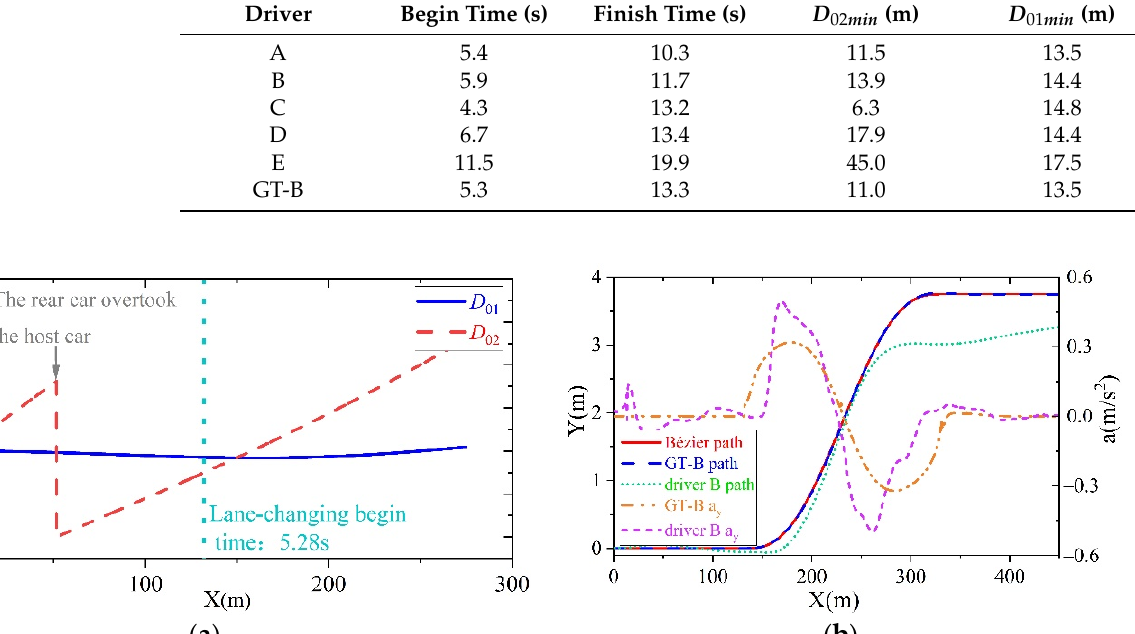
Figure 13. Vehicles’ interval, vehicle path and lateral acceleration in Case Ⅰ . ( a ) Decision-making time and distance. ( b ) Vehicle path and lateral acceleration.